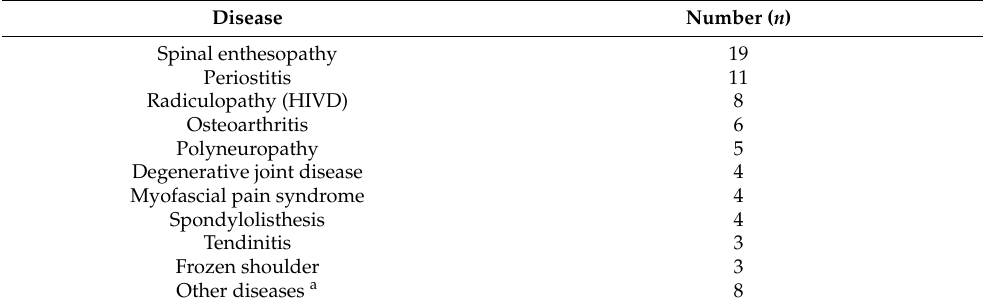
Table 1. The disease classification of patients who received Intravenous Laser Irradiation of Blood